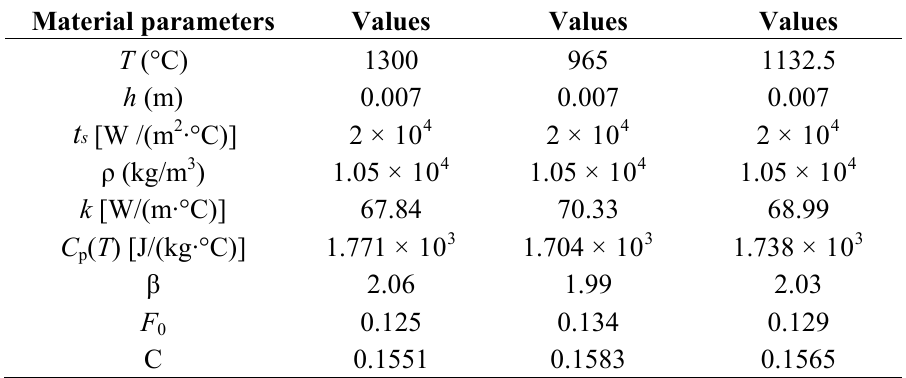
in the condition of T (max), T (min) and 2